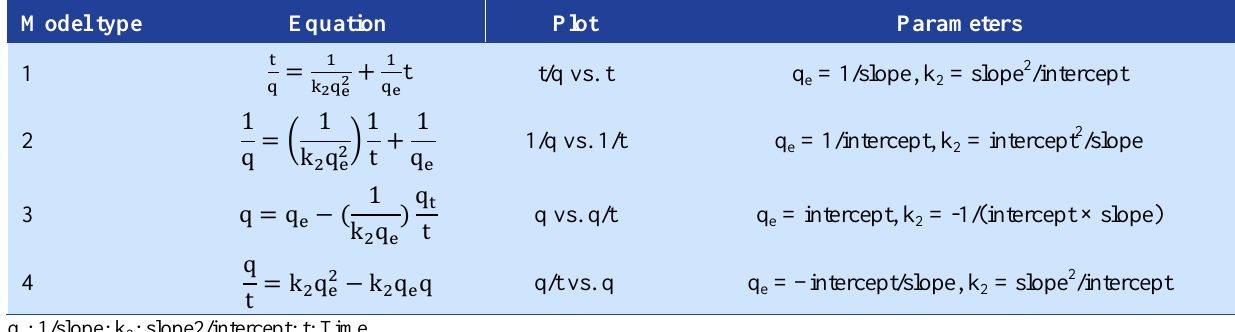
Table 1. Linear forms of pseudo second-order kinetic model Model